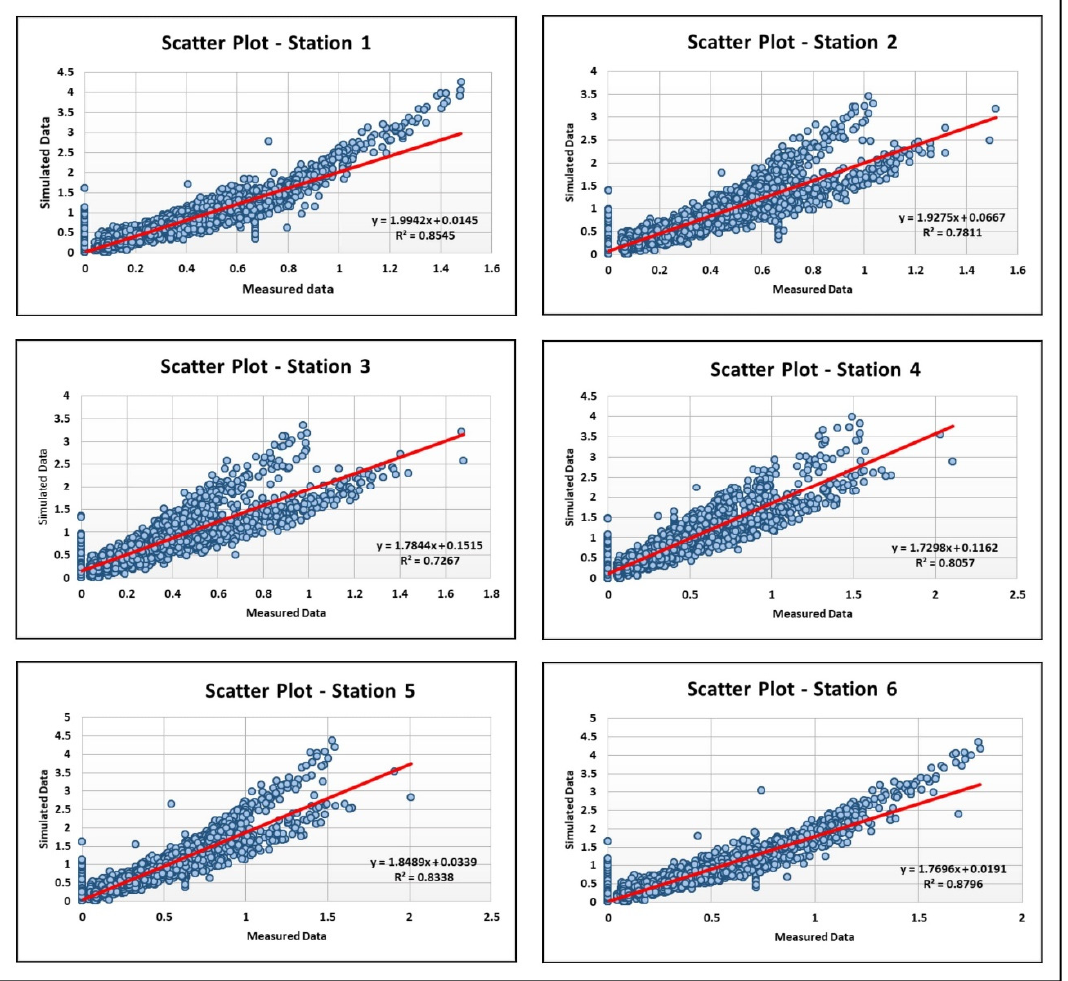
Figure 22. Scatter plot graph of stations A–F graphically showing the correlation of the two param-